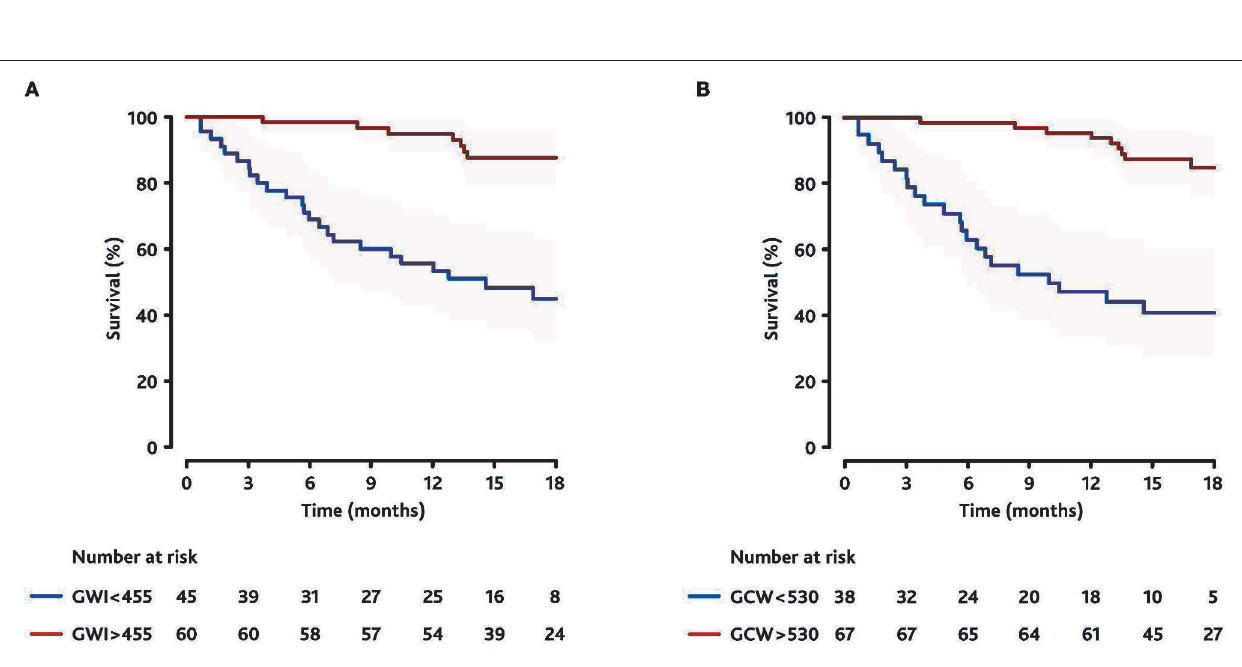
patients with a GWI < 455, the 1-year event-free survival rate was 53.3% (95% CI: 37.9–66.7%) and the 18-month